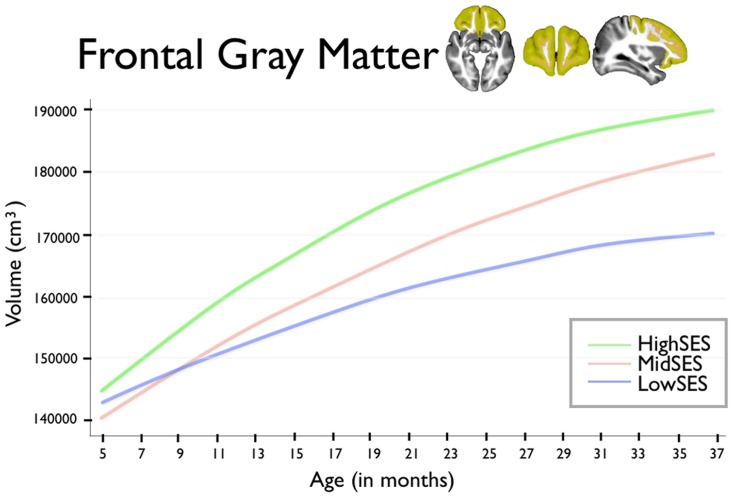
This figure shows frontal lobe gray matter volumes for group by age.Age in months is shown on the horizontal axis, spanning from 5 to 37 months. Total gray matter volume is shown on the vertical axis. The blue line shows children from Low SES households; children from Mid SES households are shown in red. The green line shows children from High SES households.